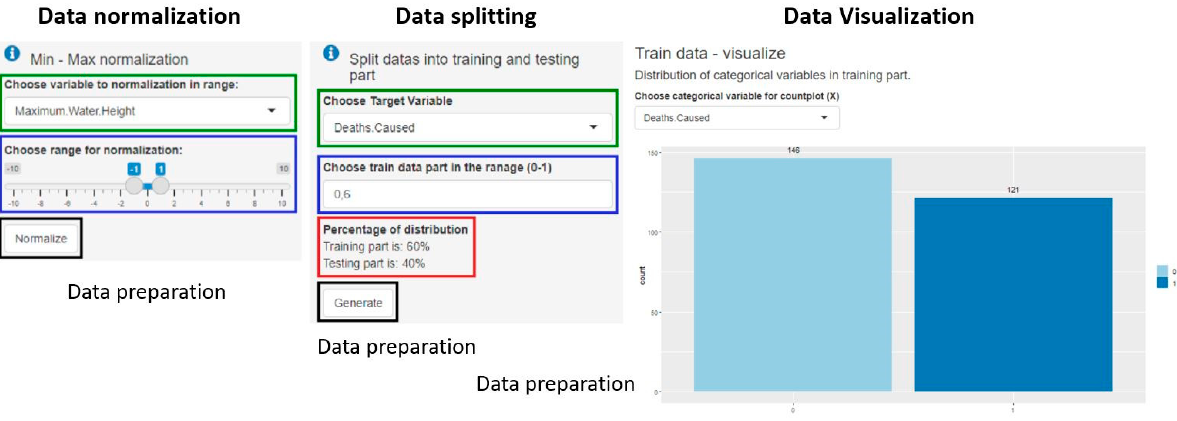
Figure 8. Algorithms/parameters settings, interpretability of a model (modelling and evaluation).